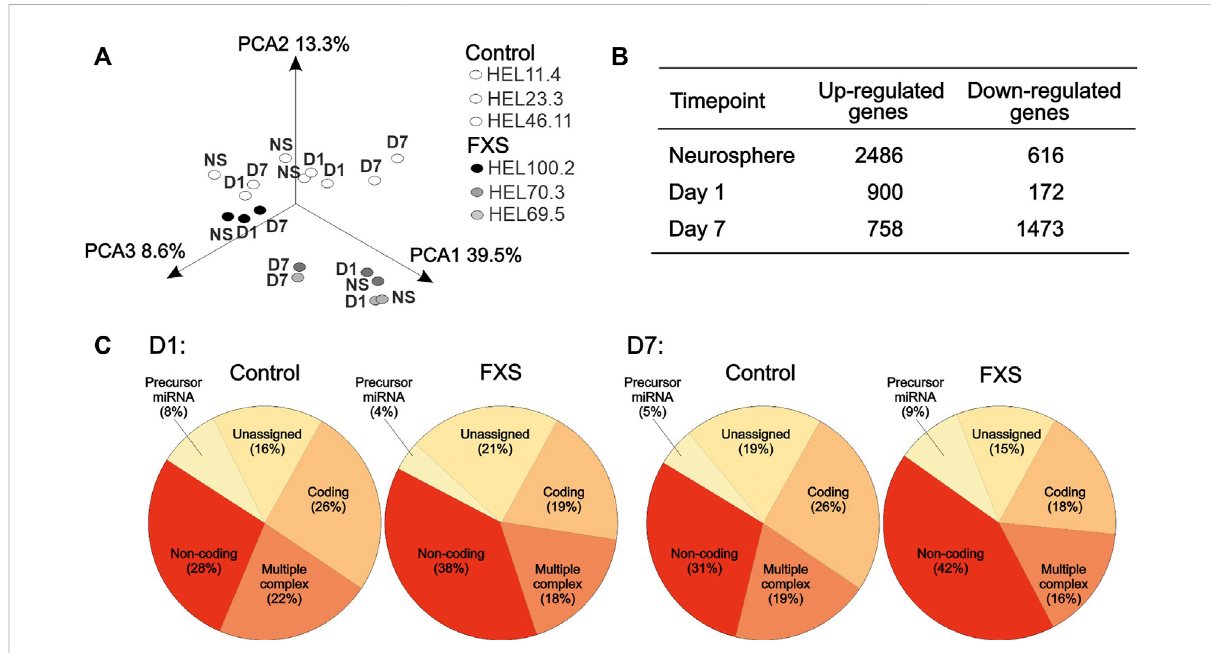
FIGURE 2 Exploratoryanalysis oftranscriptomedata. (A) Principalcomponentanalysis displayssegregation ofneurosphere(NS), day1(D1), andday7(D7) NPCs derived fromFXS(HEL69.5,HEL70.3, and HEL100.2) and control (HEL46.11, HEL23.3, andHEL11.4)human iPSClines. (B) Number ofdifferently expressed transcripts (log2 fold change < − 1 or > 1 and unadjusted p -value < 0.05) identi fi ed between FXS and control NPCs before adjustment for